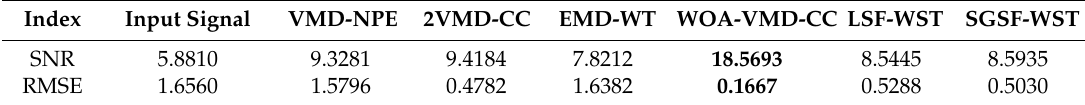
Table 1. Denoising evaluation indexes of different algorithms.